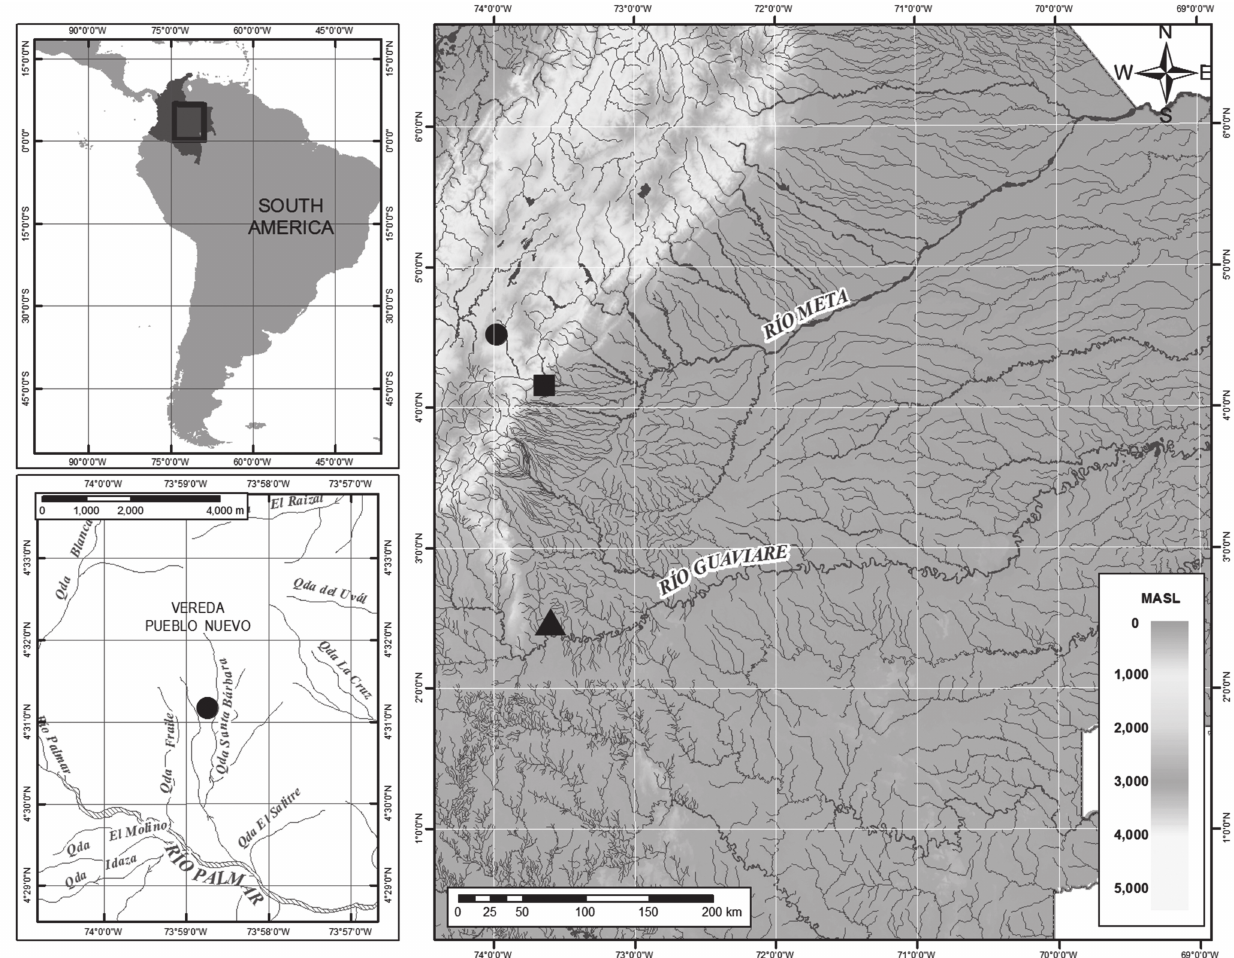
Fig. 6. Map of Middle Eastern region of Colombia showing the geographic distribution of Trichomycterus steindachneri (circle): Cundinamarca, Ubaque, vereda Pueblo Nuevo, quebrada El Charco, 04°31’10.3”N 73°58’44.6”W, T. dorsostriatus (square): Meta, Villavicencio, 04°09’12”N 73°38’06”W and T. migrans (triangle): Meta, Serranía La Macarena, tributary creek of río Guayabero, 02°28’21”N 73°35’43”W. Inset at lower left corner corresponds to enlargment of distribution region of T. steindachneri